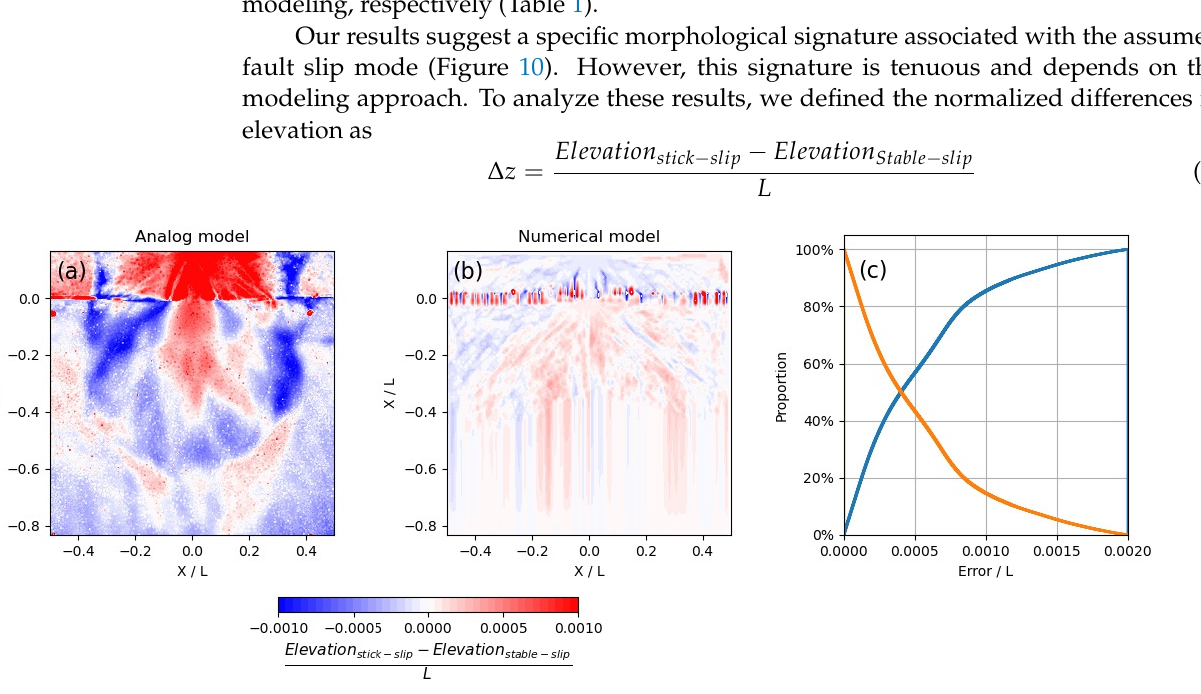
Figure 10. Stick-slip versus stable fault slip mode. Positive differences in elevation indicate larger vertical displacements for stick-slip compared to stable slip mode. ( a ) Result from experimental modeling associated with 20 seismic events with a return period of 180 s and a vertical displacement of 0.34 mm. ( b ) Result from numerical modeling for 20 seismic events with a return period of 1800 yr and a vertical displacement of 3.4 m. ( c ) Repeatability of analog models. Blue and orange lines give the cumulative and reversed cumulative normalized error, respectively. At each point, this error is defined as the difference in elevation between analog models with the same properties and undergoing similar tectonic forcing. A perfectly reproducible model will have a zero error.